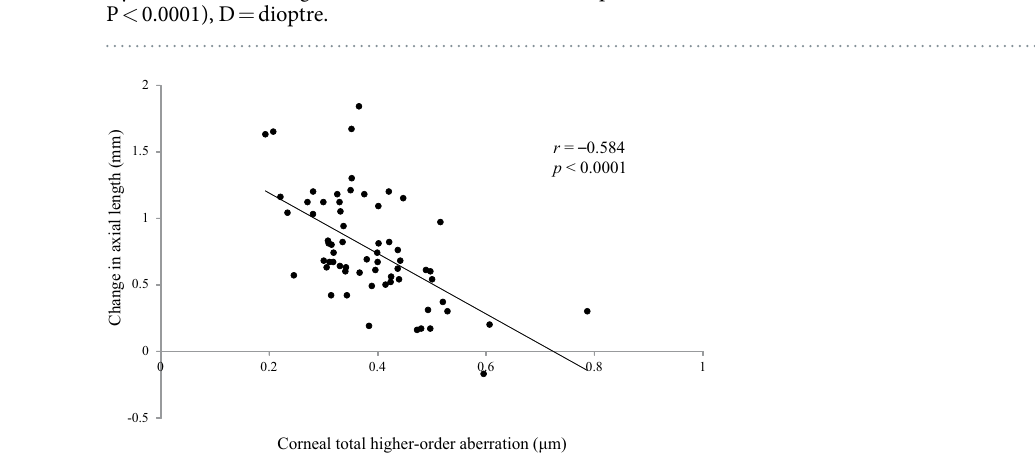
Figure 2. Scatterplots showing the averaged corneal total HOAs vs the change in axial length over 2 years. There was a significant correlation between the parameters (Pearson correlation coefficient; r = − 0.584, P <